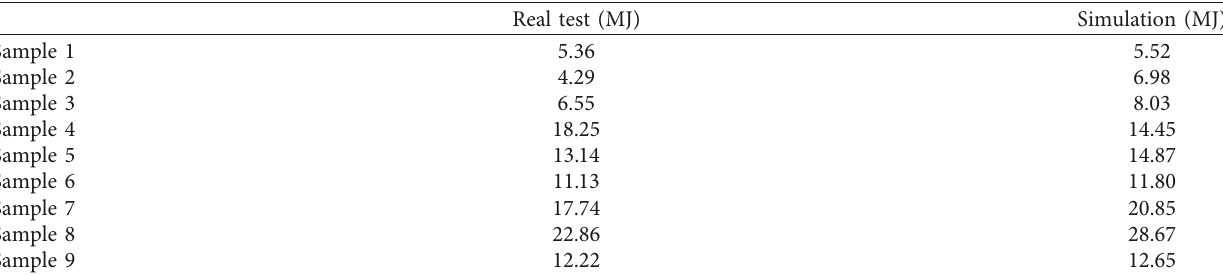
Figure 13: Simulated flat crushing results. (a) Comparison of total deformations of samples, (b) stress and (c) strain of each sample, and (d) Poisson’s ratio for each sample. Table 6: SEA values in real tests and